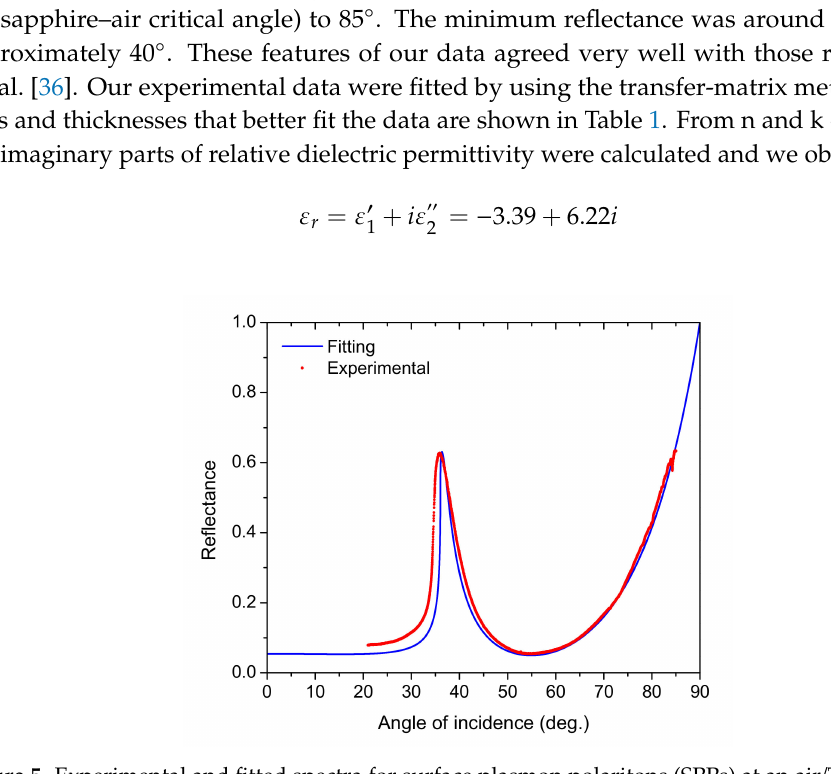
Figure 5. Experimental and fitted spectra for surface plasmon polaritons (SPPs) at an air / TiN interface, by using a sapphire D-shaped prism as